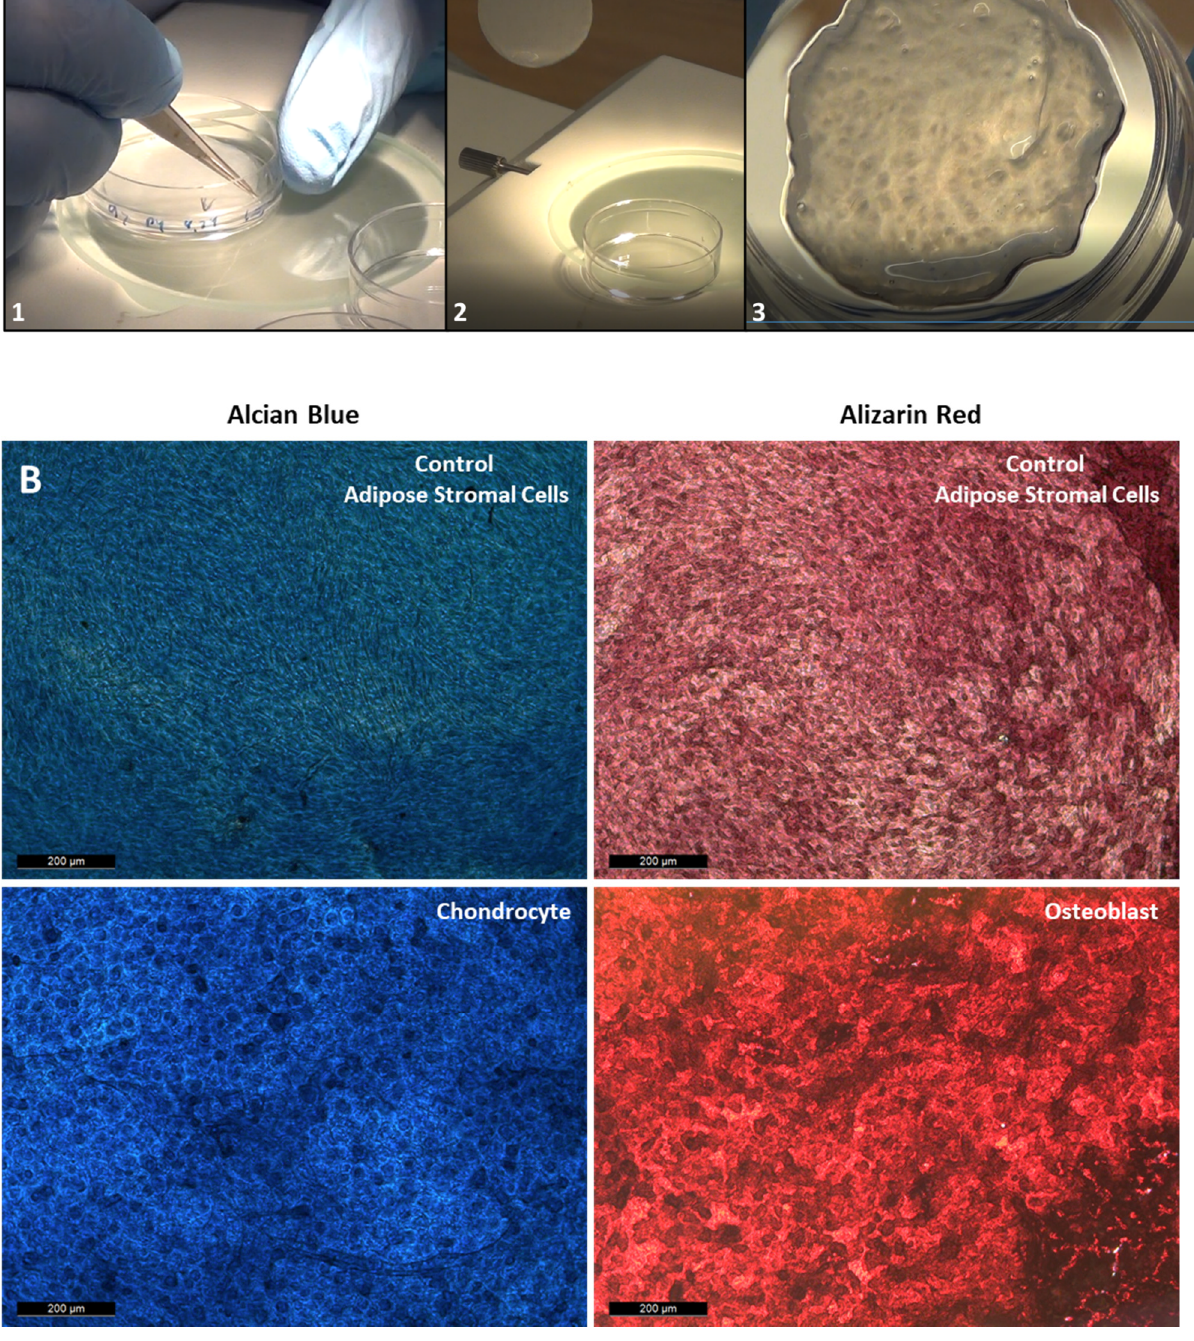
Figure 3. ( A ) Harvesting and lifting of the ASC cell sheets with a CellShifter. 1 : Cutting of the cell sheet edge, with forceps; 2 : lifting of the cell sheet using a cell shifter; 3 : transferred cell sheets in a new cell culture dish. ( B ) Dyeing of the ASC cells with Alcian blue and Alizarin Red after 2 and 3 weeks of differentiation into chondrocyte and osteoblast, respectively. (Scale bar are 200 μ m).